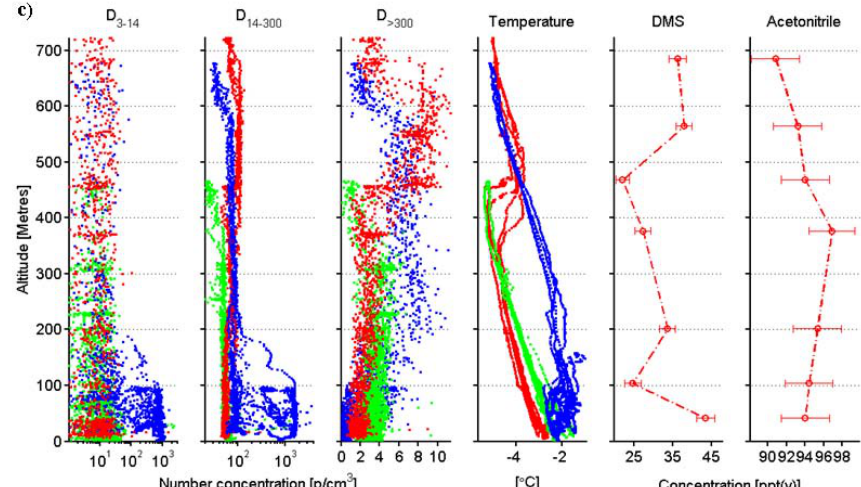
Fig. 9c. Vertical profiles of aerosol particle number concentration, temperature, and dimethyl sulphide (DMS) and acetonitrile concentrations (error bars give the 95% confidence interval) during ASCOS 2008 expedition helicopter flights, Period 3: 08:40–09:16 UTC, 28 August (DoY 241) 2008 (red); 08:30–09:16 UTC, 29 August (DoY 242) 2008 (blue); 13:07–14:07 UTC, 29 August (DoY 242) 2008 (green).